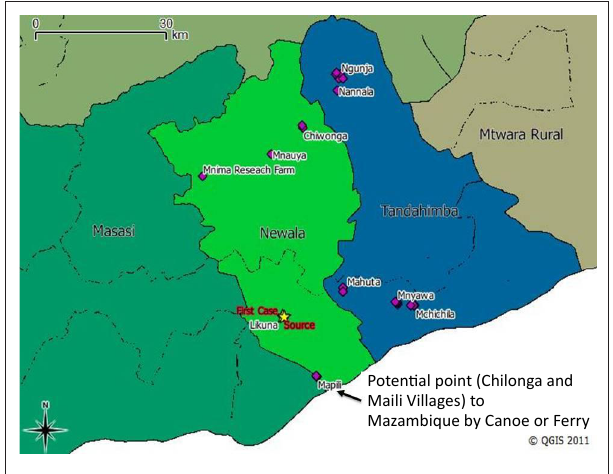
Potential point (Chilonga and Maili Villages)